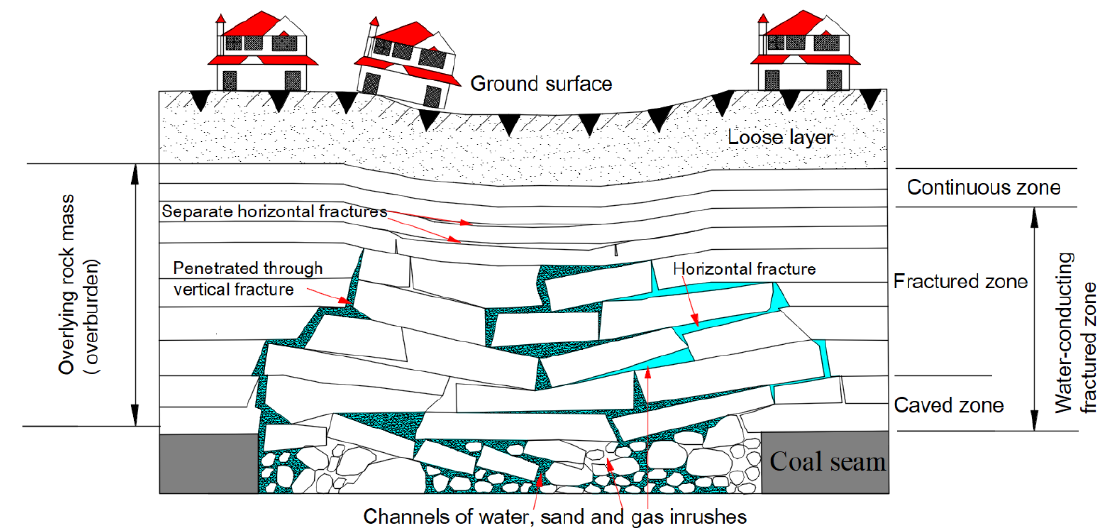
Figure 1. Fracture zones in a rock mass.